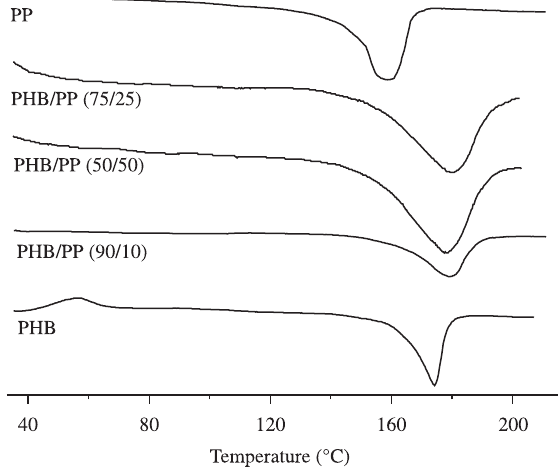
Figure 1. DSC profiles of PHB, PP and PHB/PP blends.